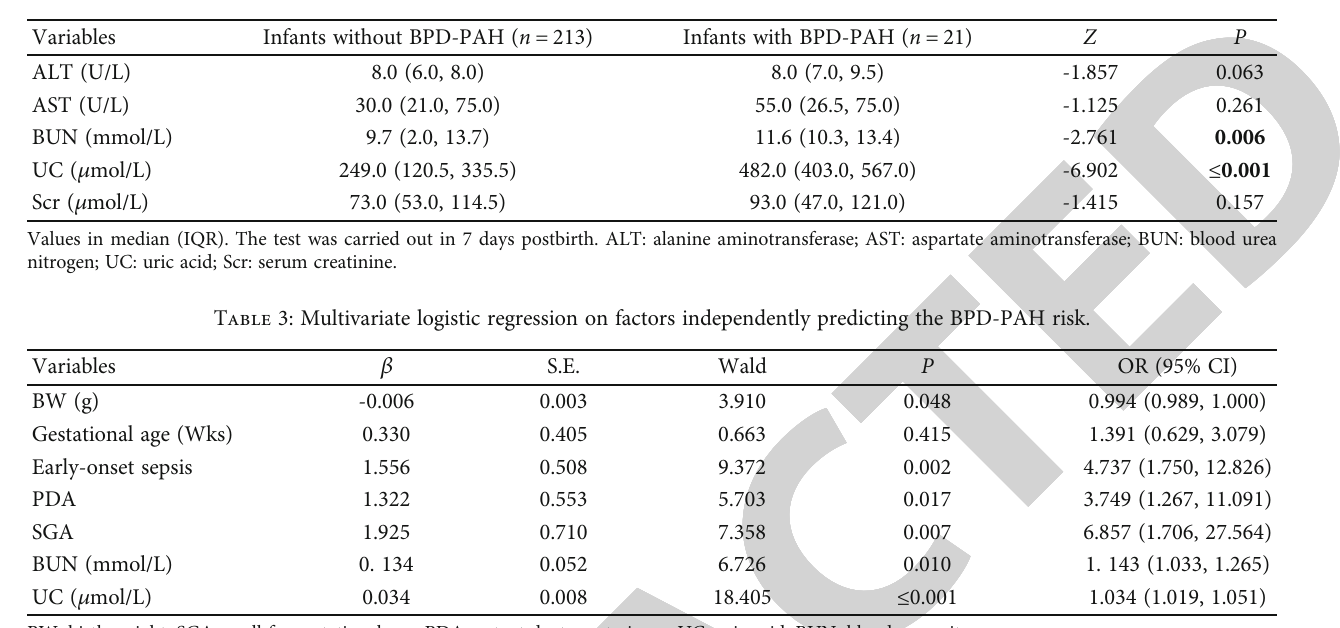
Table 2: Biochemical markers features in 234 EPIs based on BPD-PAH.